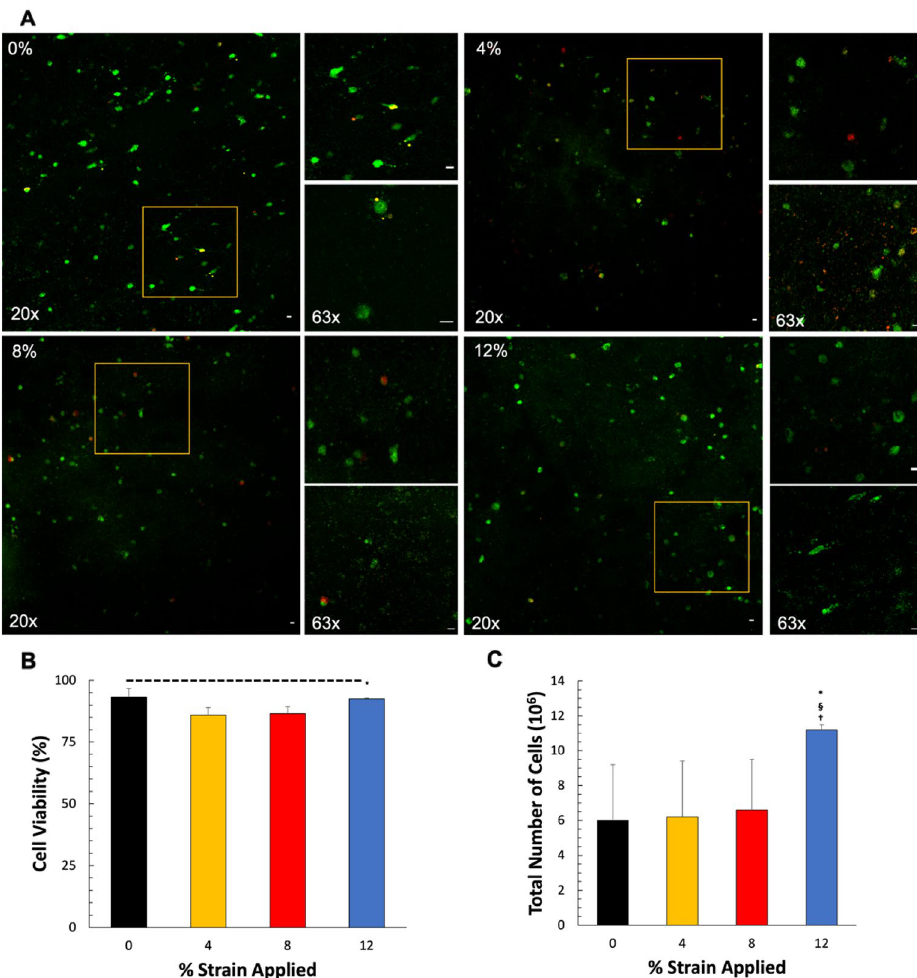
Figure 2. Mechanical loading increases cellularity within 3D tissue analogues. ( A ) Live/dead images of residing cells within 0%, 4%, 8%, and 12% mechanical strain 3D tissue analogues. ( B ) Percentage cell viability within 3D tissue analogue, and ( C ) total number of cells within 3D tissue analogue. Live cells were stained with Calcein AM (green). The scale bar represents 10 μm (n = 3). *Indicates a significant difference with respect to the 0% strain group (control). § Represents a significant difference between 8 and 12% mechanical strain groups, and † represents a significant difference between 4 and 12% mechanical strain groups, each with P <